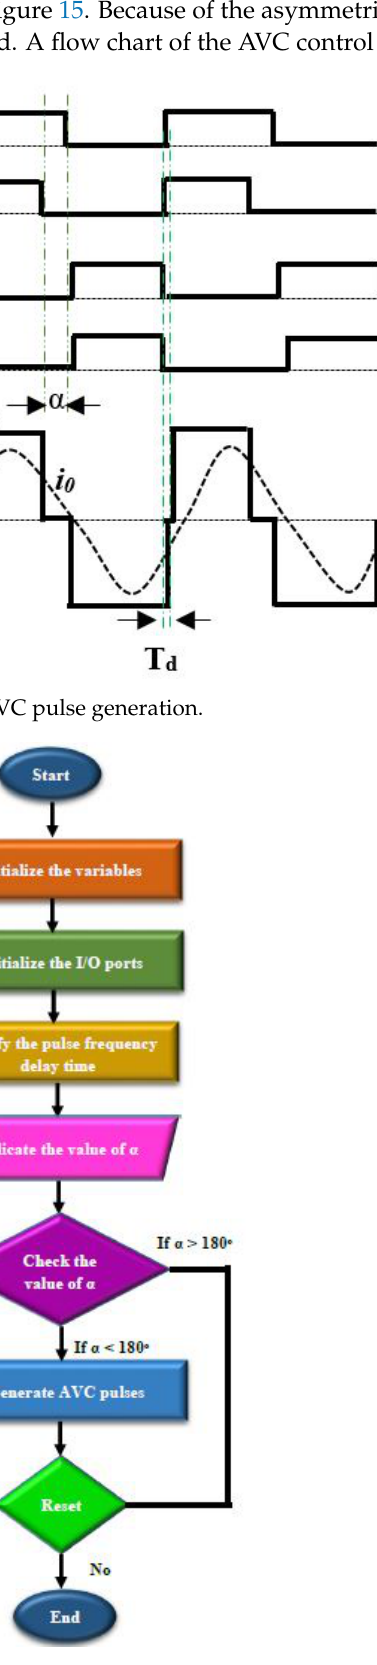
Figure 16. Flow chart of AVC control